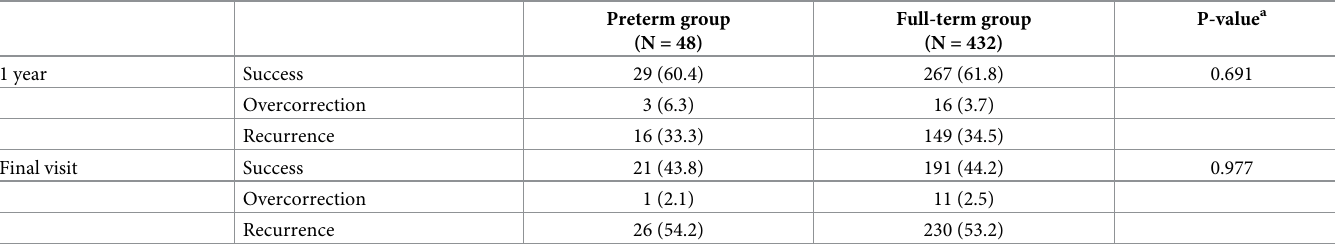
Table 3. Surgical outcomes at 1 year and final follow-up visit after surgery in preterm and full-term groups.